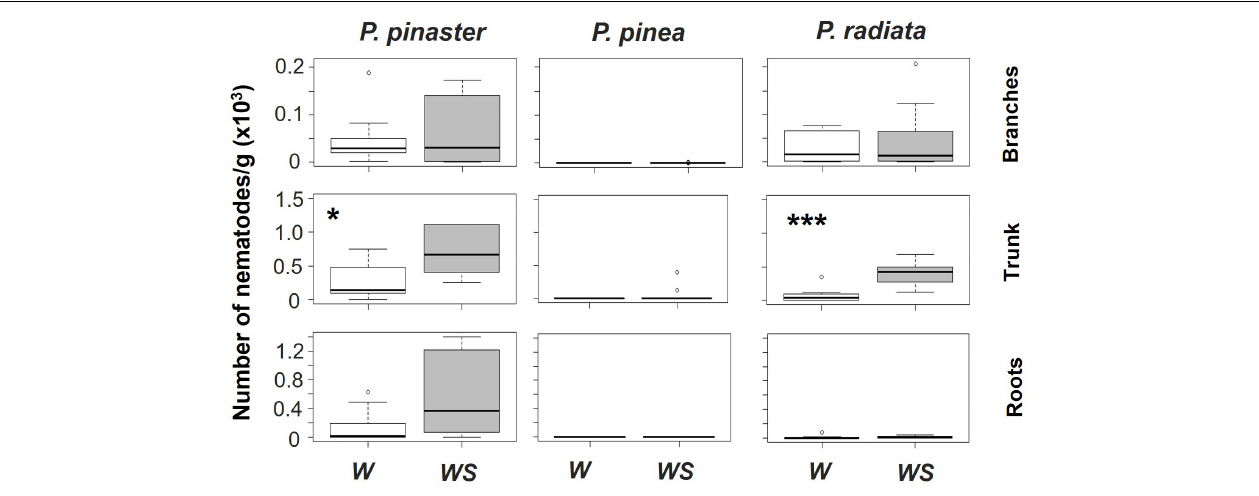
FIGURE 4 | The number of Bursaphelenchus xylophilus /g of plant biomass at specific components of the plant (branches, trunk or roots) by Pinus species and water regime (W – watered, WS – water stressed), considering both temperature treatments. Significant differences between water regimes within each species are represented by an asterisk (* p < 0.05 and *** p < 0.001). Note that y -axis has different